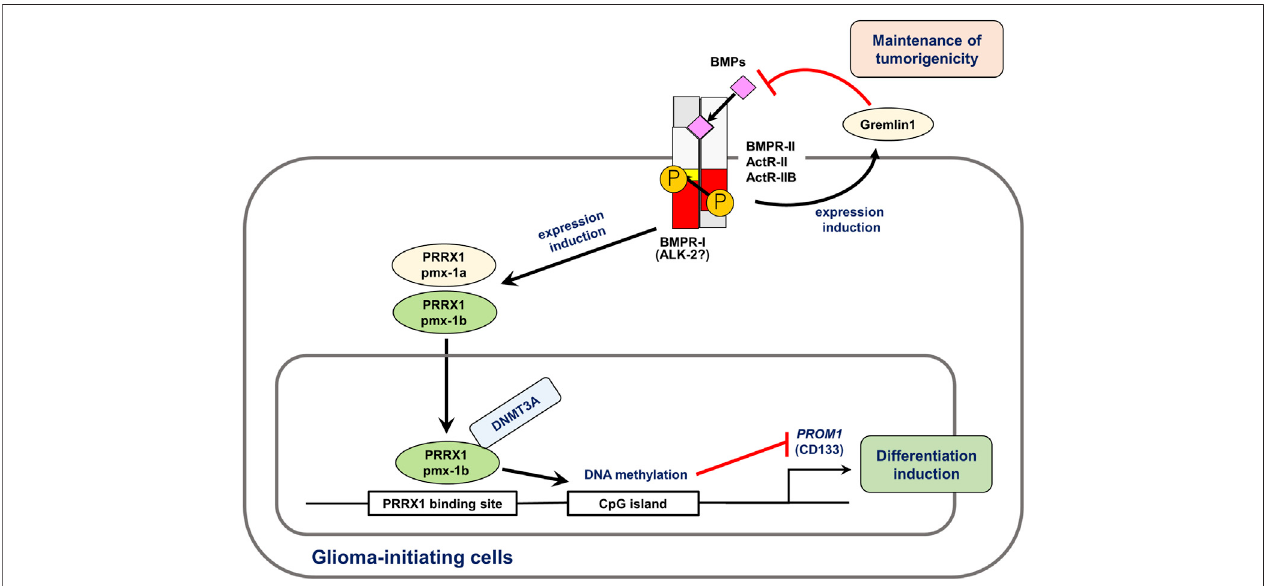
FIGURE 3 | BMPs induce differentiation and apoptosis of glioma-initiating cells. BMPs regulate expression of various target genes in glioma-initiating cells. In this fi gure, the roles of PRRX1 (Tanabe et al., 2022) and gremlin1 (Yan et al., 2014) are shown. Of the two splice isoforms of PRRX1, only pmx-1b induces differentiation of glioma-initiating cells. Through interaction with DNMT3A, pmx-1b induces the methylation of the PROM1 gene promoter and suppressed the CD133 + glioma-initiating cell population. BMPs induce the expression of gremlin1, an antagonist of BMP, which is involved in the maintenance of pro-tumorigenic functions and stem cell properties of glioma-initiating cells. Modi fi ed from Tanabe et al. (2022).